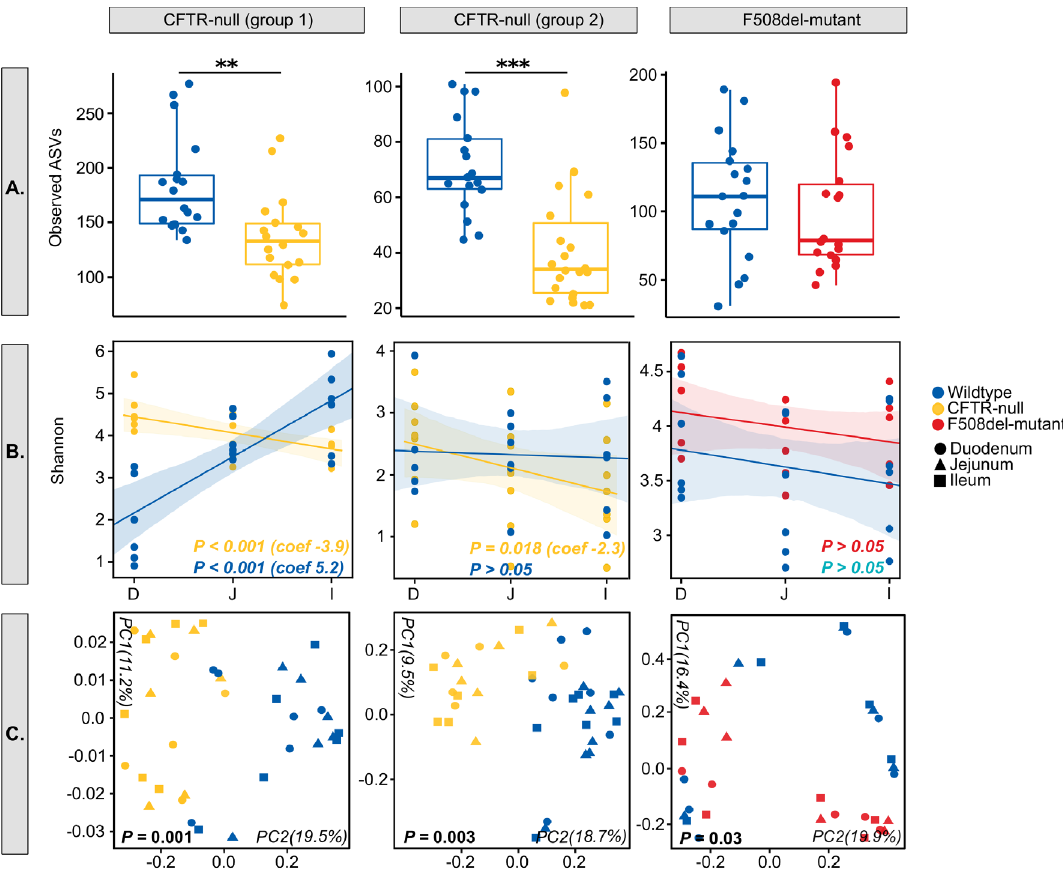
Figure 1. ( A ) Box and whisker plots showing microbial diversity of the mucosa-attached microbiome in CF and WT littermate mice. Boxplots display the median as the midline whilst the perimeters of the box display the 1st and 3rd quantiles of the data. Significance between groups is represented by asterisks; * P < 0.05; ** P < 0.01; *** P < 0.001. ( B ) Linear mixed effects regression plots showing the relationship between Shannon diversity and small intestinal region (D; duodenum, J; jejunum, I; ileum). P -values and coefficient values are listed for each genotype. ( C ) Principal co-ordinates analysis (PCoA) plots of Jaccard distances for mucosa-attached microbiome samples from CF and WT littermate mice. Colours represent CFTR genotype and shapes represent small intestinal regions. The percentage of variation captured by each PCoA axis is indicated. P -values from ANOSIM analysis of Jaccard dissimilarity matrices are